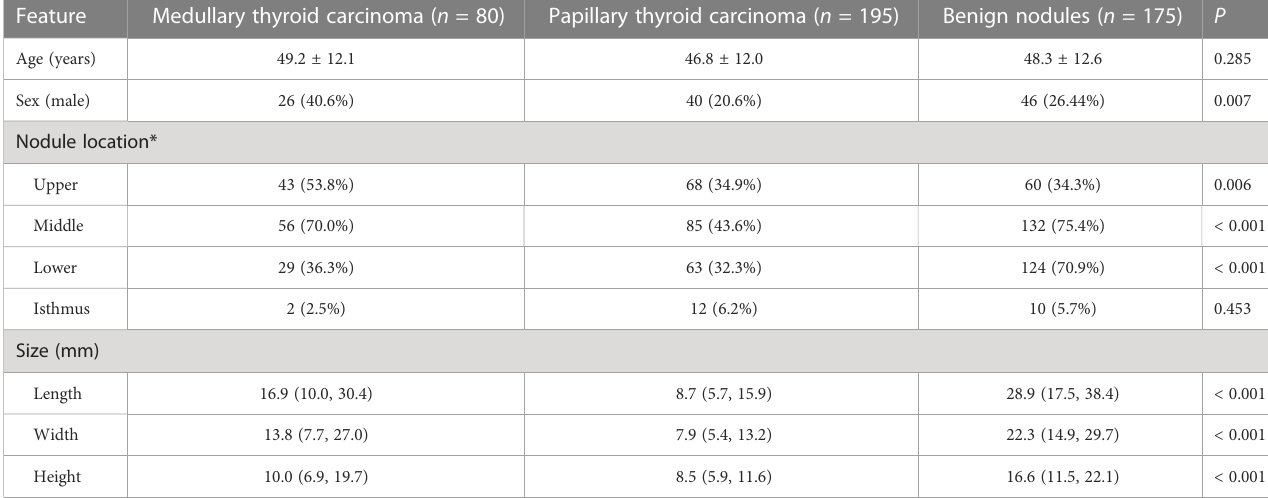
TABLE 1 Baseline characteristics of